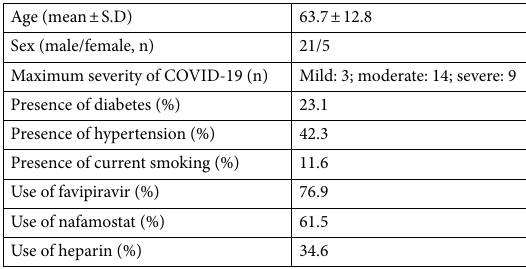
Table 3. Characteristics of the COVID-19